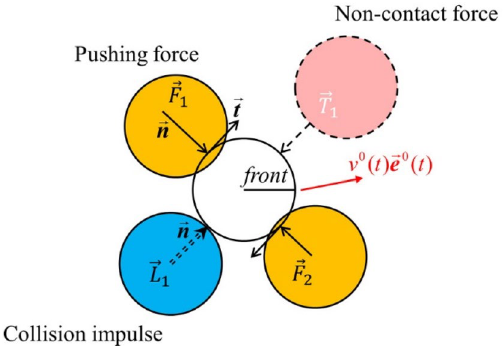
Figure 1. Illustration of interactions of the white pedestrian with others. The physical contacts included a collision impulse (with the blue pedestrian) and pushing forces (with orange pedestrians). Additionally, the dynamics process of the individuals was also subject to the non-contact force (with the pink pedestrian) in −→ e 0 ( t ) of the individual desired speed were also the force-based model, while the size v 0 i ( t ) and direction i determined by the surrounding individual in the velocity-based